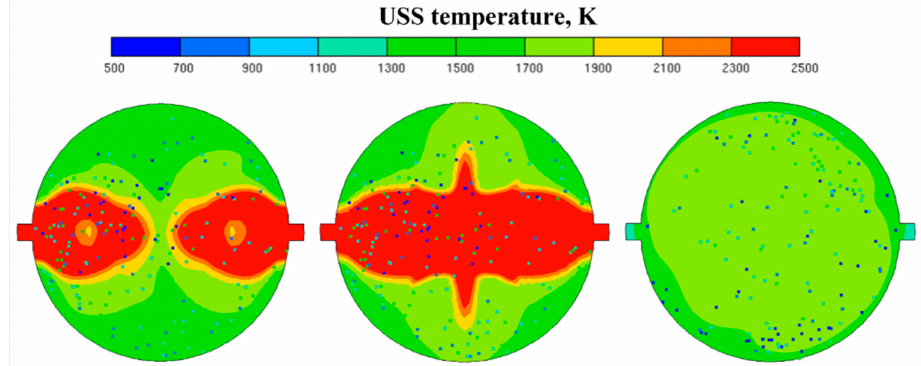
Figure 2. The calculated snapshots of gas temperature during a time interval of 0.1 s after one of multiple detonation shots in the 100-dm 3 spherical reactor partly filled with 1-mm-size waste particles. Dots represent waste particles; dot color represents particle residence time; f = 5 Hz, P ≈ 0.1 MPa.